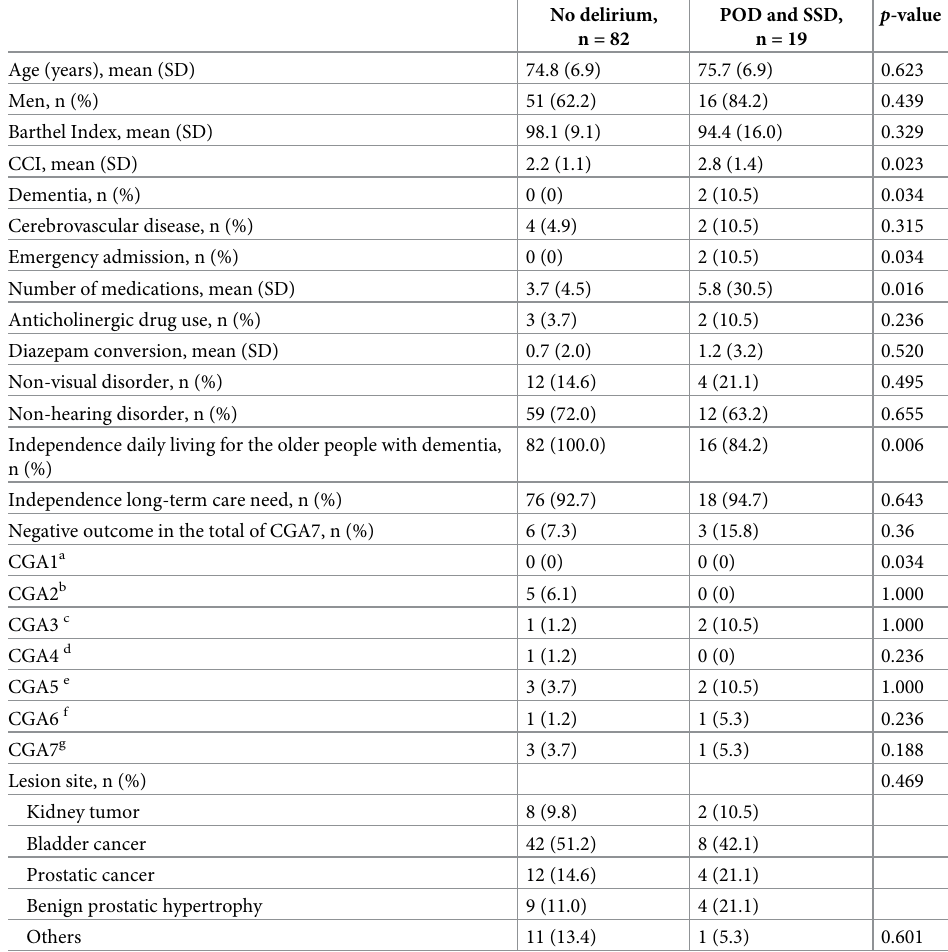
Table 3. Differences in demographic characteristics (no delirium vs. POD and